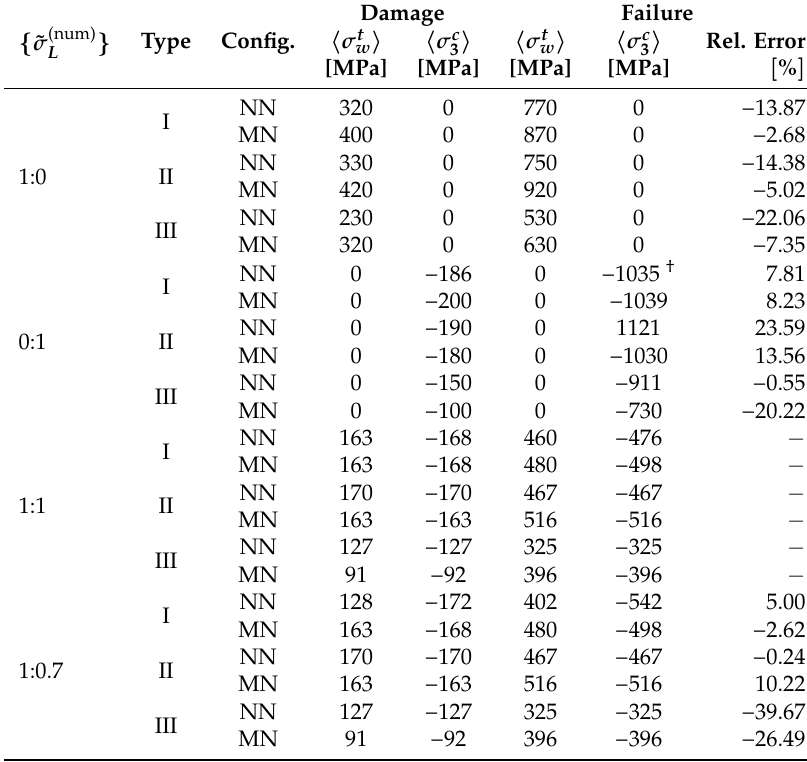
Table A3. Results of the damage and failure identification for selected load